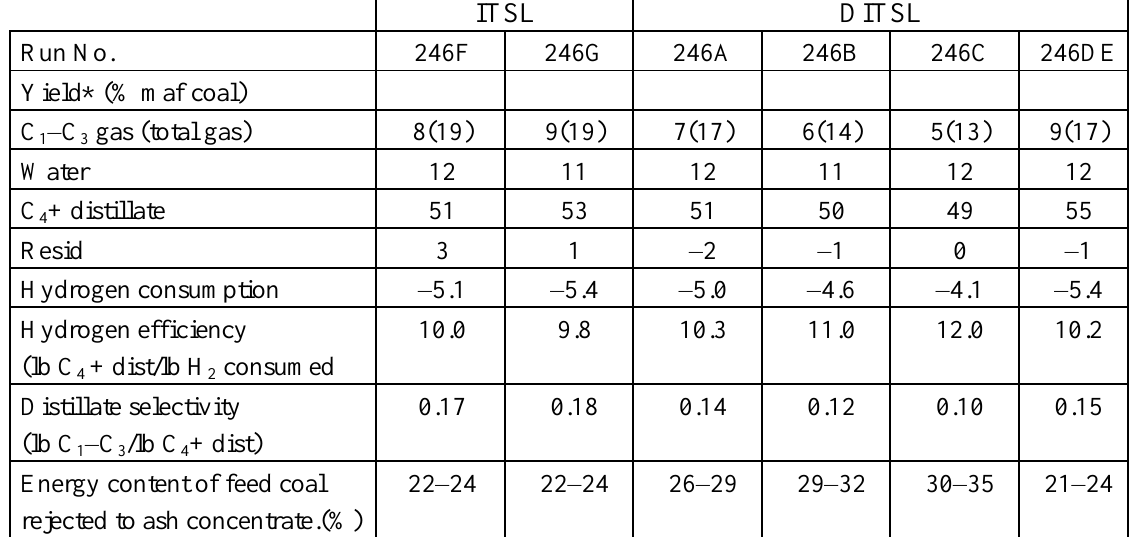
Table 12. Process yields for Wilsonville Pilot Plant- two stage Mode- Illinois Bituminous Coal. ITSL DITSL Run